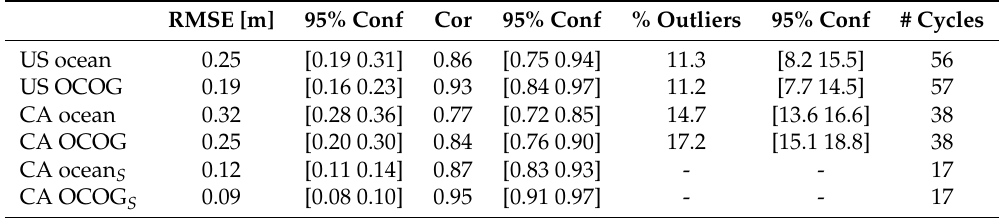
Table 1. The median and 95% confidence interval of the validation measures; RMSE, Pearson correlation and the percentage of outliers, for the two retrackers Ocean and OCOG. The subscript s indicates solution based on summer data only. RMSE